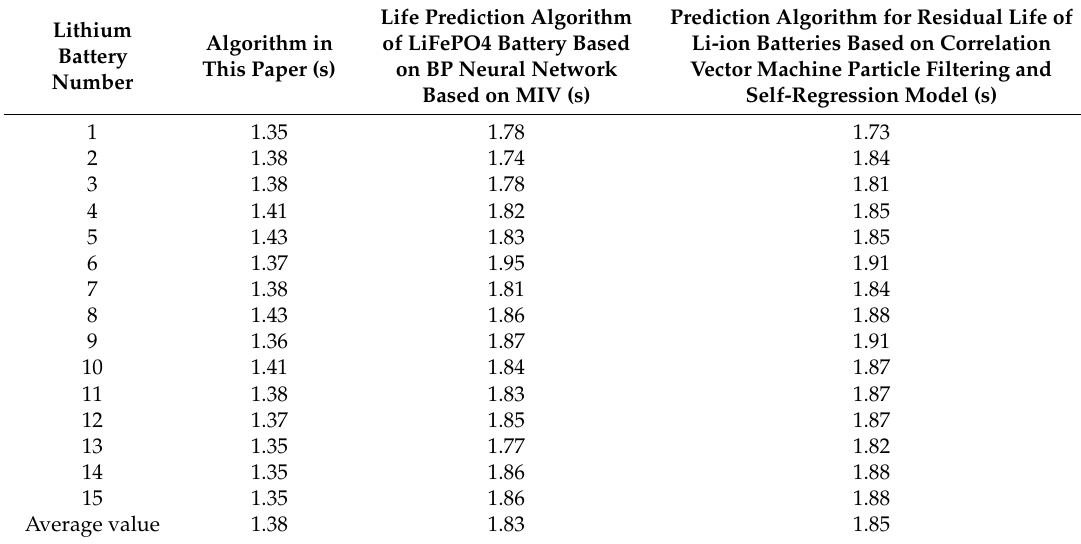
Table 6. The comparison of the cycle life budget (s) of energy storage in a lithium battery by using different algorithms.